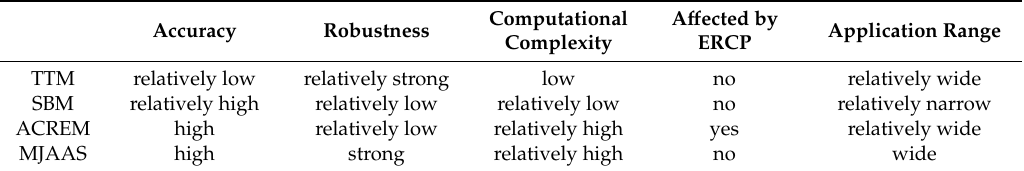
Table 1. Pros / cons of the four algorithms. TTM: trajectory tracking method; SBM: slope-based method; ACREM: azimuth chirp rates estimation method; MJAAS: modified joint range spatial-variant autofocus and azimuth scaling algorithm.